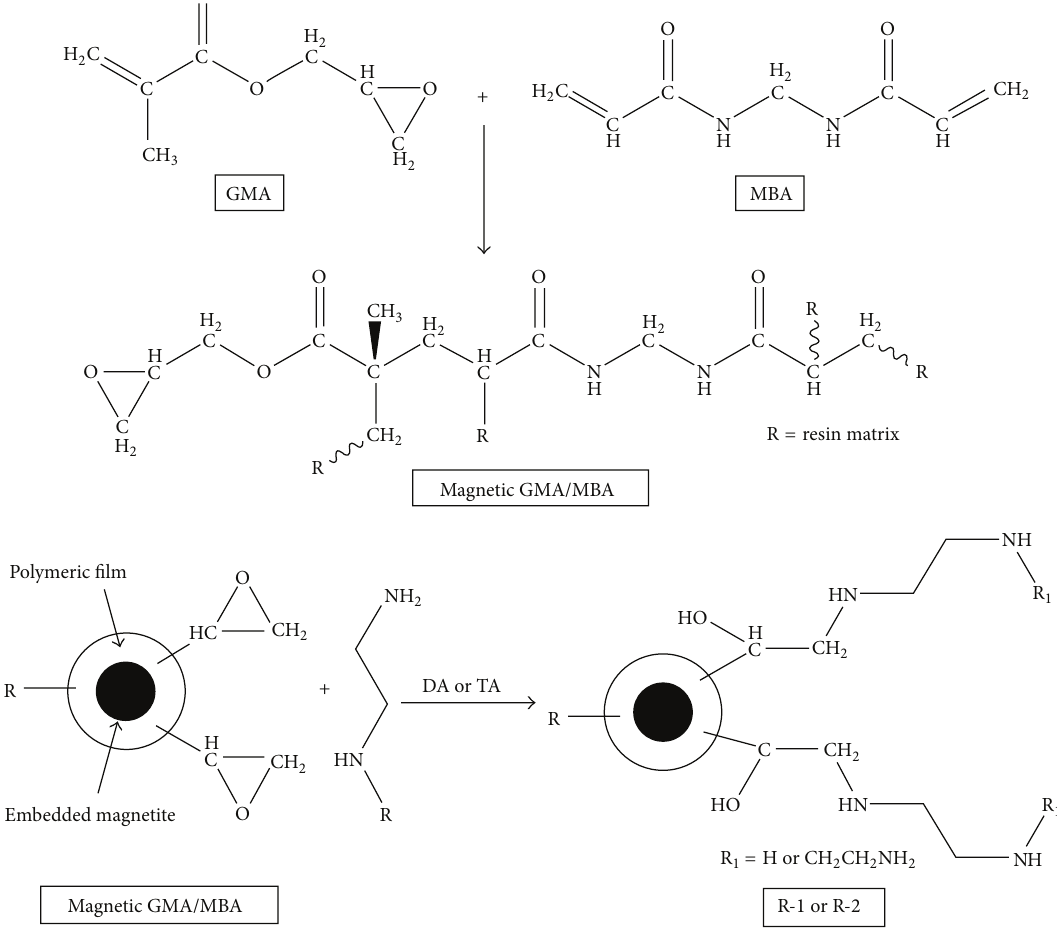
Scheme 1: Chemical preparation of resins containing nanomagnetite.